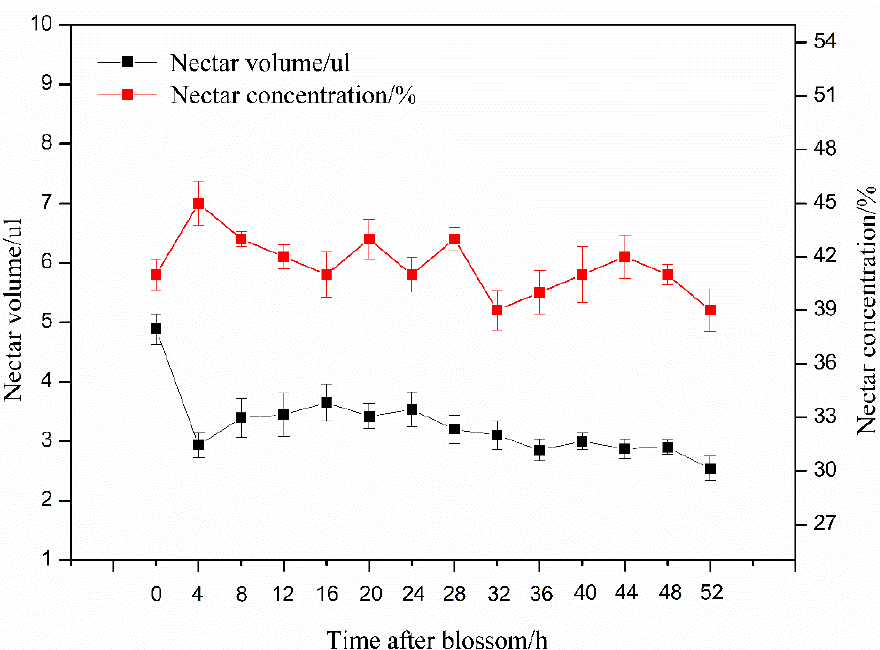
Figure 7. The volume and concentration of nectar every 4 h after blossom. The red line refers to nectar concentration and the black line refers to nectar volume.